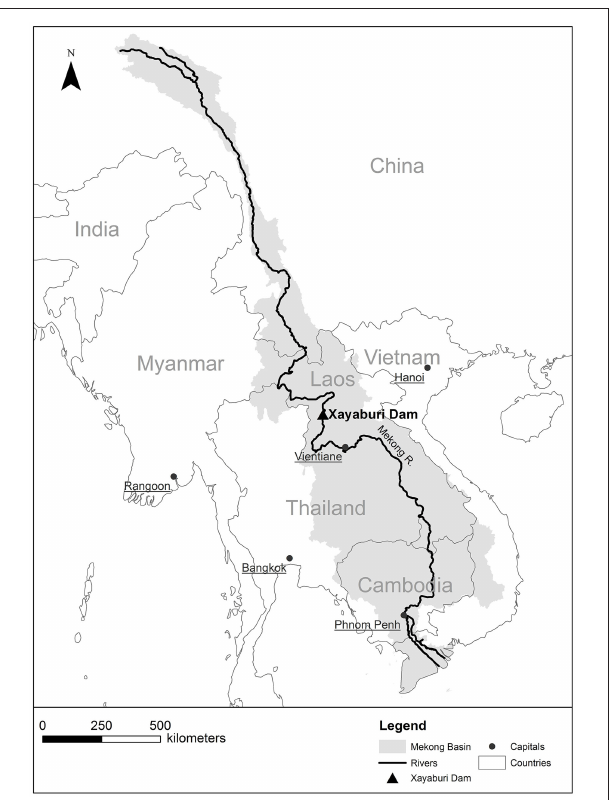
FIGURE 2 | Location of the Xayaburi dam, Source: Own